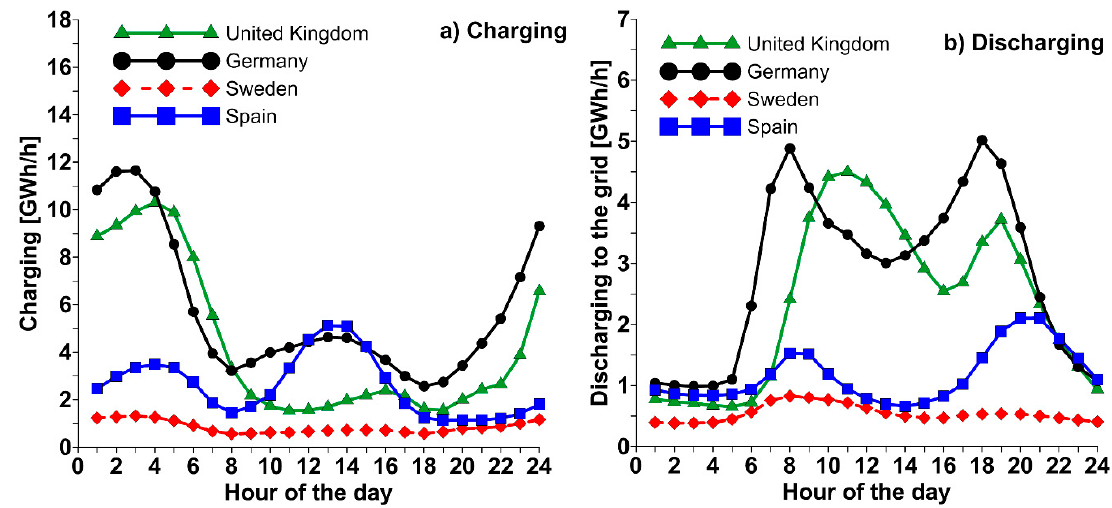
Figure 7. Levels of charging ( a ) and discharging back to the electricity grid ( b ) for the EV fleet for an average day in the four investigated countries.